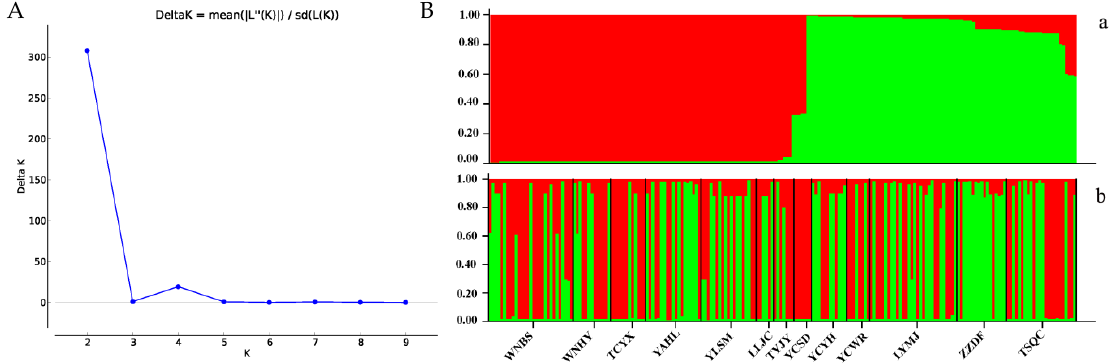
Figure 4. Population genetic structure. ( A ) Estimation of the best subpopulation numbers based on the appropriate K value: the mean ∆ K values among the 10 runs reached a maximum at K = 2. ( B ) Genetic structural plot of 13 P. orientalis populations based on structure analysis. a K = 2, sorted by Q via STRUCTURE. b K = 2, samples displayed in order of collection. Red for Pop-A, and green for Pop-B in a and b.